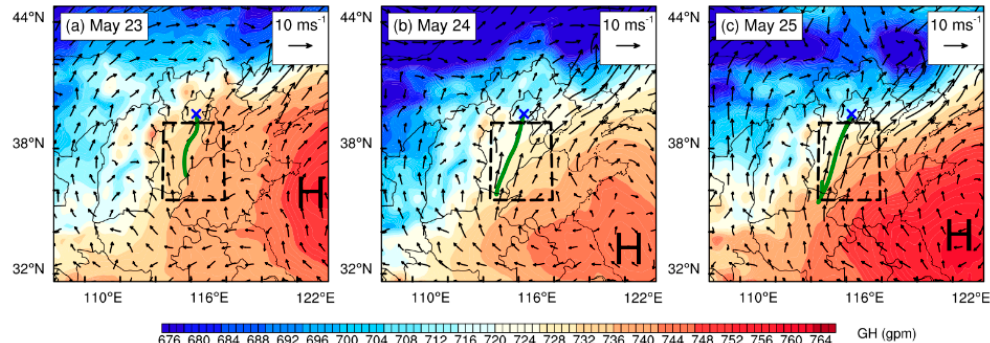
Figure 6. Spatial distributions of 925-hPa geopotential height (GH) and horizontal winds in the simulation domain at 18:00 LT on ( a ) 23 May, ( b ) 24 May, and ( c ) 25 May, 2015, derived from the atmospheric reanalysis of European Centre for Medium-Range Weather Forecasts. The location of the NH 3 monitoring site is marked by the blue cross, and 24-h backward trajectories arriving in the site are shown as the green lines. The dashed rectangle adjacent to Beijing indicates the regions using the emission zero-out method in the WRF-Chem simulation. The high-pressure systems in the southern seas are denoted by the text “H”.